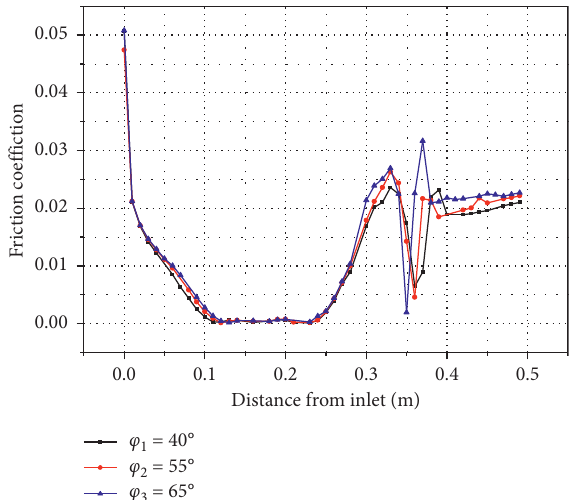
Figure 11: Variation of friction coefficient along upper channel wall for φ 1 � 40 ° , φ 2 � 55 ° , and φ 3 � 65 ° .